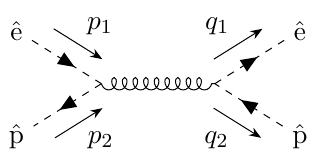
Figure 3 . Another possible contribution at α 4